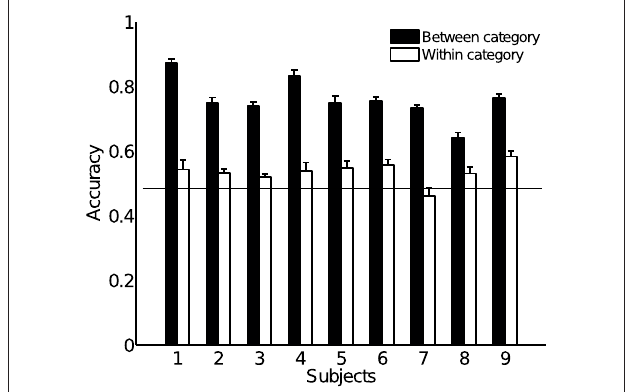
FIguRe 5 | Average classification accuracy across models using 10 to 100 topics, for each of 9 subjects (chance level is 0.5); the accuracy is broken down into classification of concept pairs where concepts are in different categories (“Between”) and pairs where the category is the same (“Within”). Error bars are across numbers of topics, chance level is 0.5.